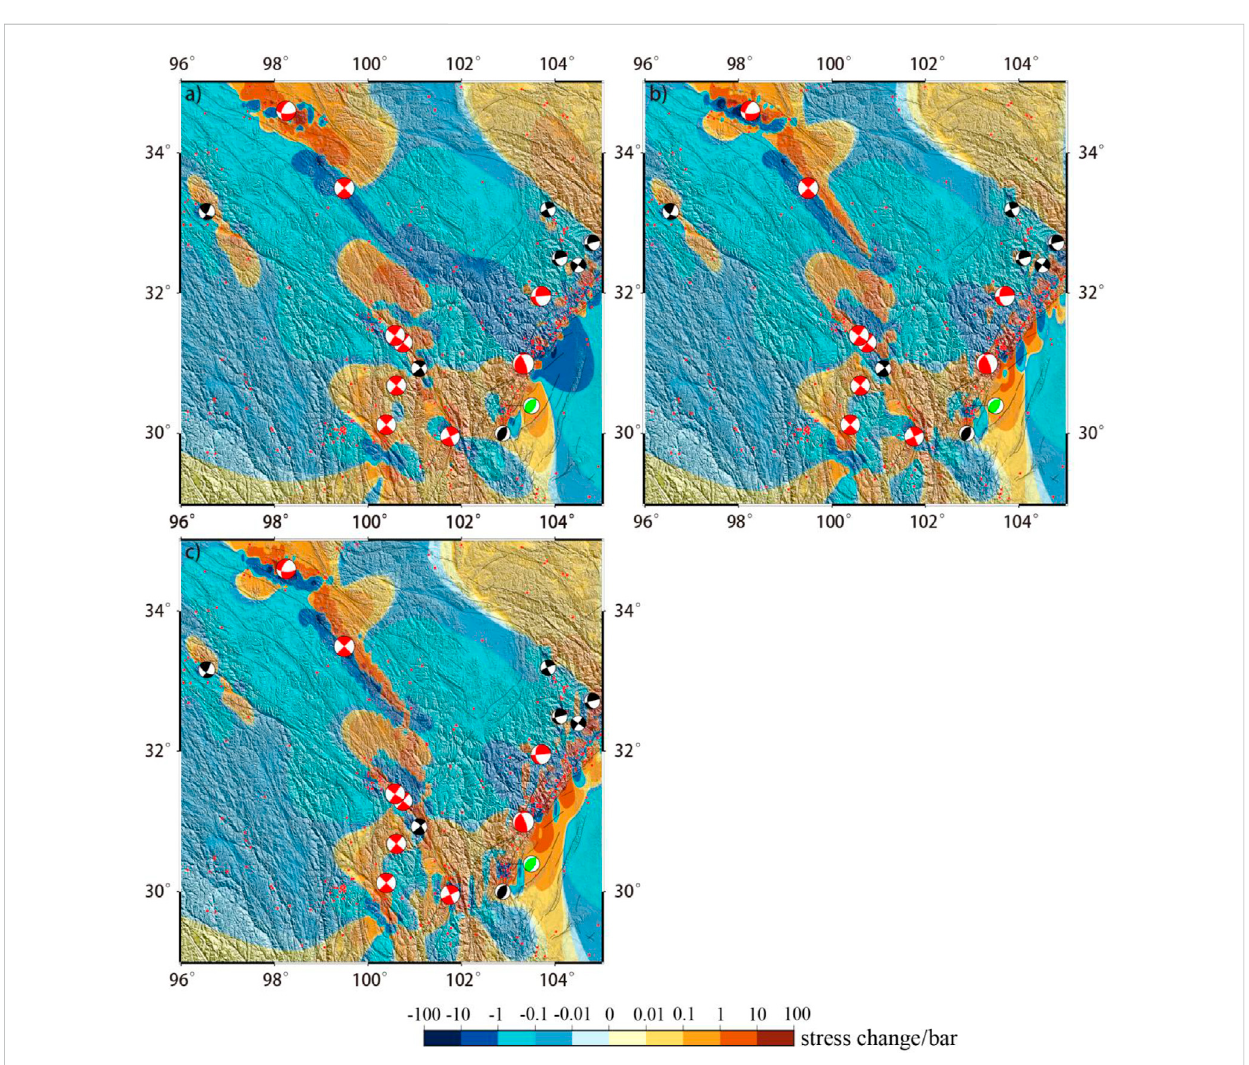
FIGURE 8 Impacts of historical earthquakes, at depths of 12 km, 16 km, and 20 km, on the Coulomb stress change contour map of the Lushan earthquake in 2022. (A) Contour map of Coulomb stress change at a depth of 12 km. (B) Contour map of Coulomb stress change at a depth of 16 km. (C) Contour map of Coulomb stress change at a depth of 20